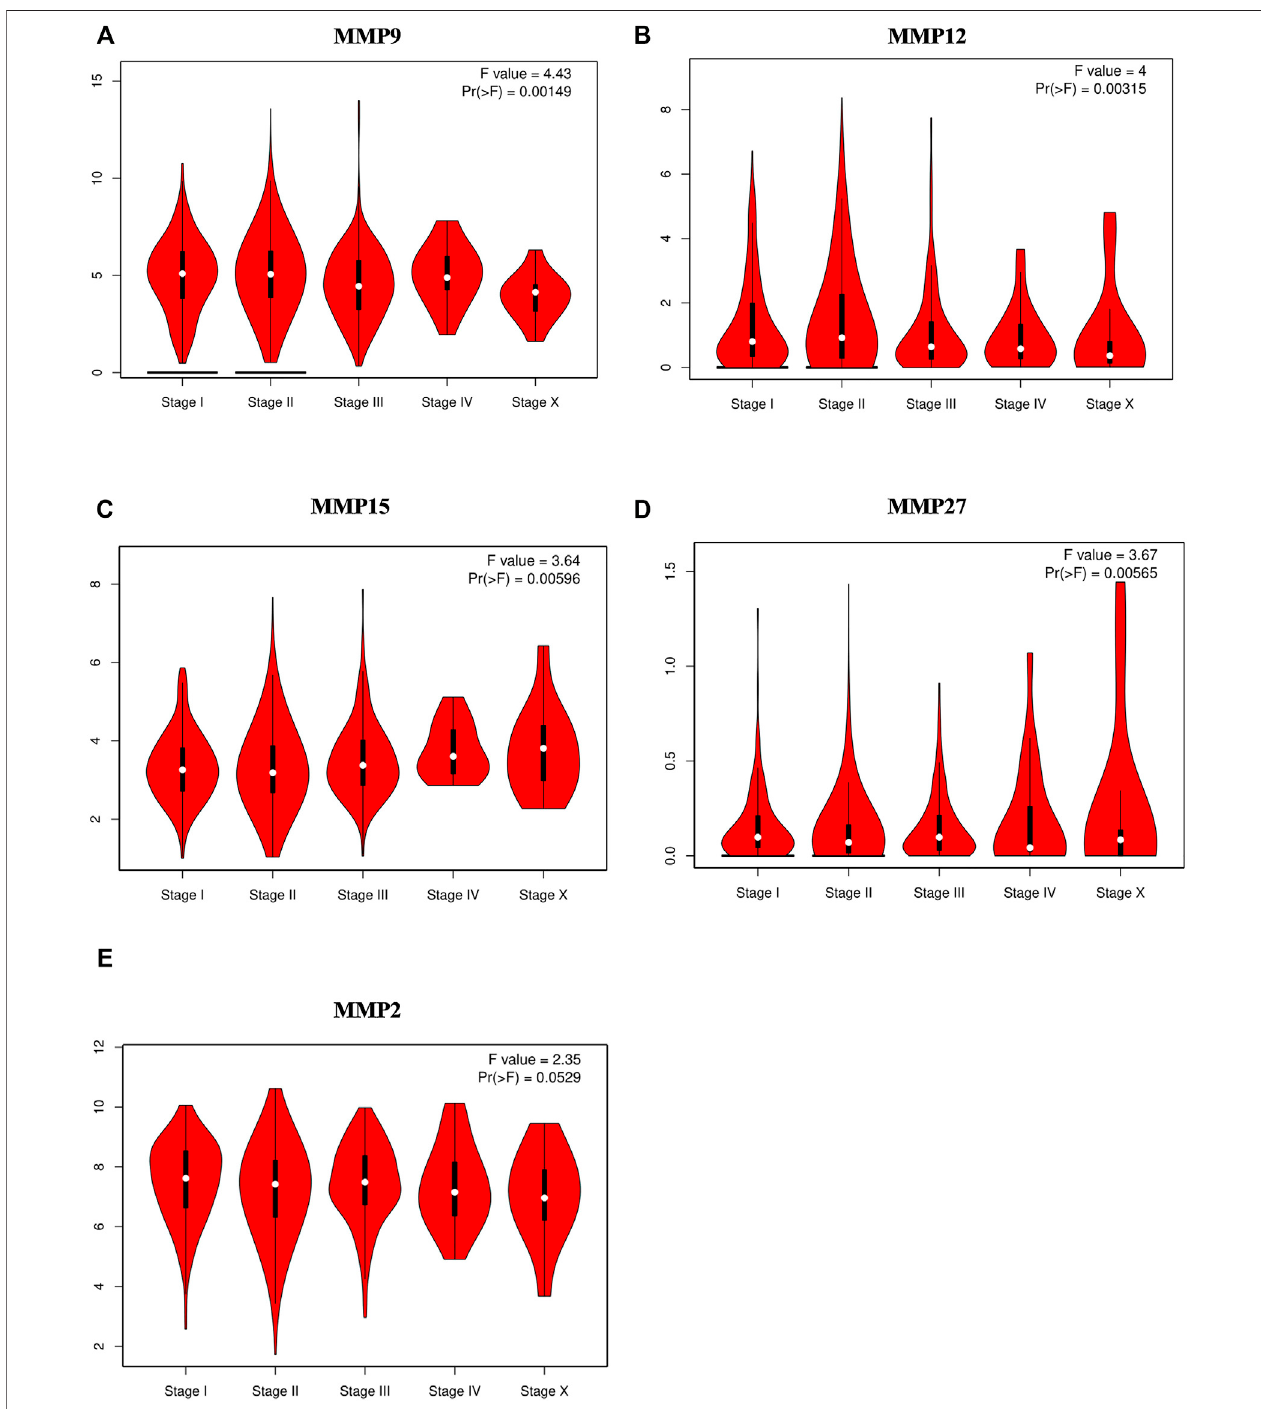
FIGURE 2 | Correlations between MMPs expression and tumor stage in breast cancer patients (GEPIA). (A,B,C,D) The expression of MMP9, MMP12, MMP15, MMP27 was correlated with the pathological stage of breast cancer patients ( p < 0.05). (E) The p value of MMP2 was close to 0.05 ( p (cid:1) 0.0529) whose signi fi cance needs further